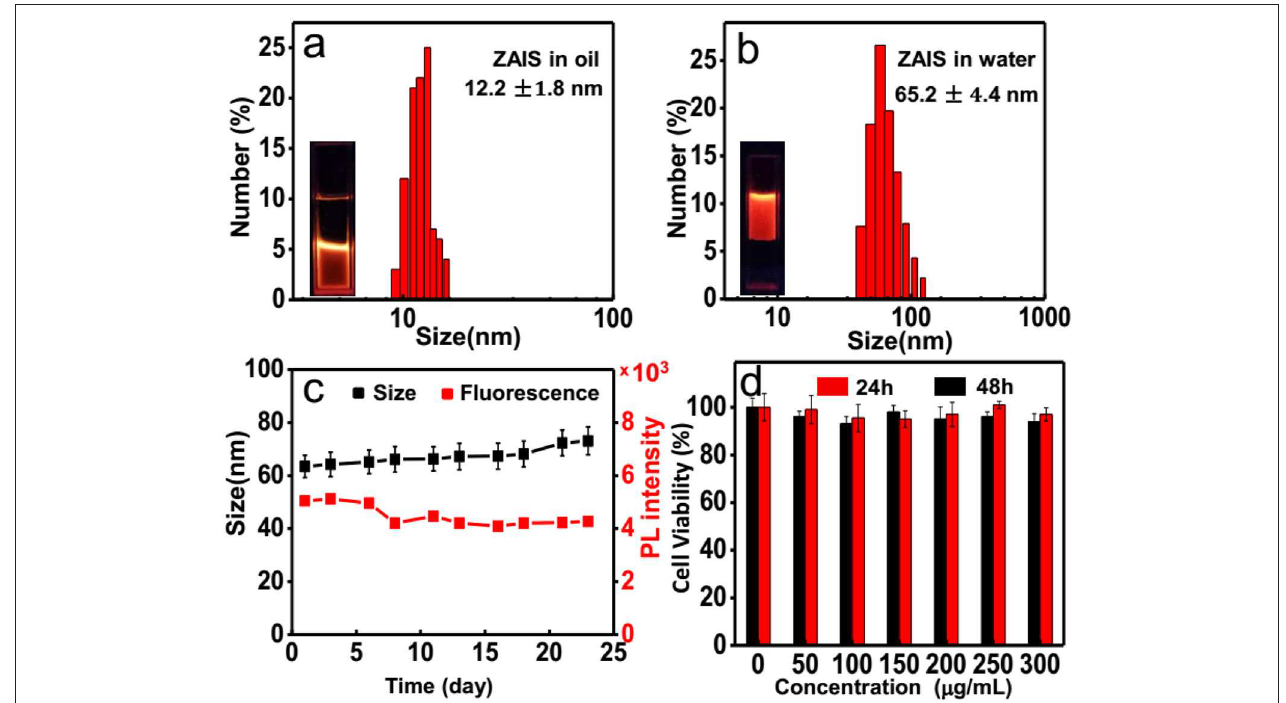
FIGURE 4 | DLS results for the ZAIS@PCDA-BA NCs (a) before and (b) after surface modification. (c) Size distribution and photoluminescence intensity changes of ZAIS@PCDA-BA NCs along with time. (d) Cell viability tests of ZAIS@PCDA-BA NCs on HepG2 cell lines at different concentrations after incubation for 24h (red) and 48h (black),